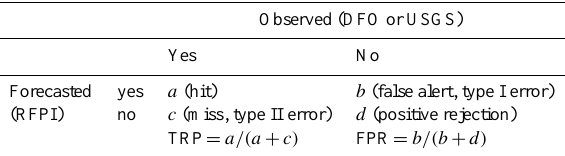
Table 1. Schematic contingency table for categorical forecasts of a binary event. The TPR, also called the hit rate or the probability of detection, is a relative number of times an event was predicted when it actually occurred; the FPR, sometimes referred to as the false alarm rate, gives a relative number of times the event was predicted when it did not occur. Observed (DFO or USGS)